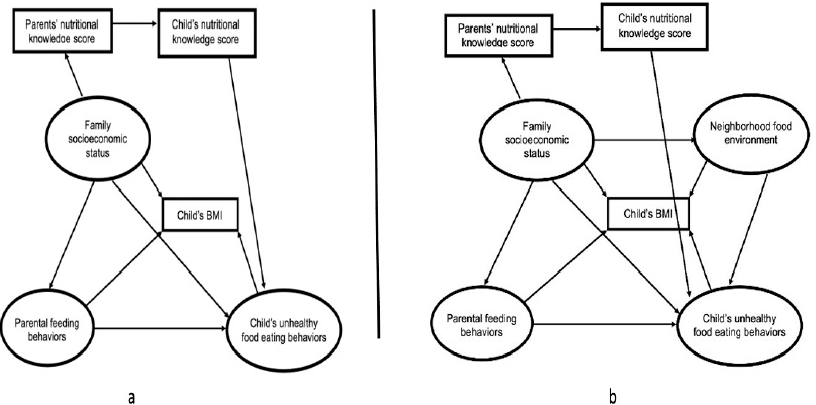
Figure 1. Research framework. Framework a : the model demonstrated the integrated effects of family, parent, and children’s characteristics on the children’s BMI.; Framework b : the model included the potential impact of the neighborhood food environment based on framework a on the children’s BMI.Child’s BMI was calculated by this formula: BMI = weight(kg)/[height(m)] 2 ).